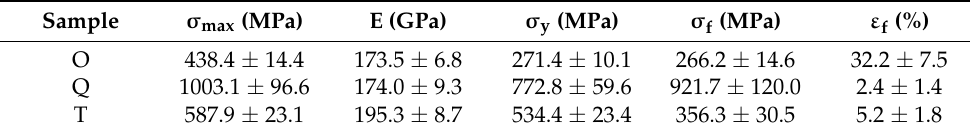
The average tensile strength ( σ max ), Young’s modulus (E, slope of the linear elastic region), yield strength ( σ y , based on 0.2% offset method), fracture strength ( σ f ), and frac- ture strain (ε f ) with standard deviations are given for O, Q, and T in Table 4. Table 4. Mechanical properties of original, quenched, and tempered samples . Table 4. Mechanical properties of original, quenched, and tempered